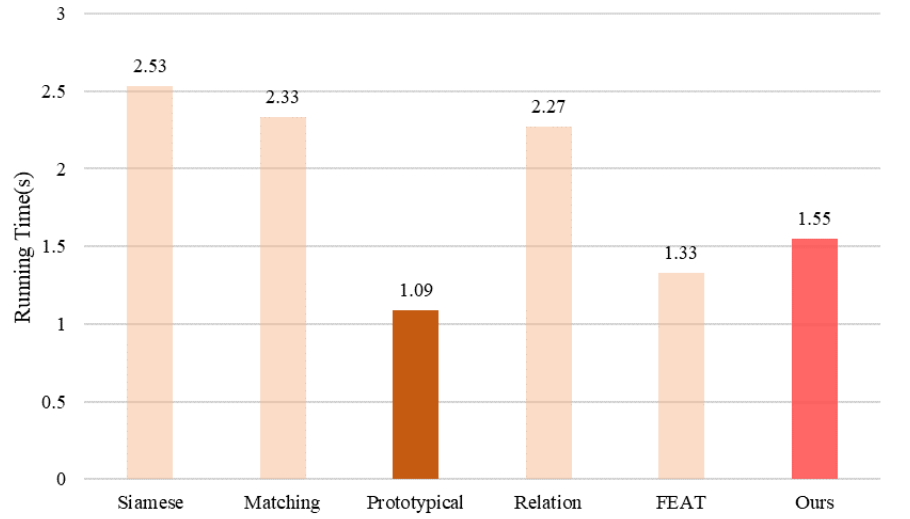
Figure 16. The running time of different methods on the MSTAR